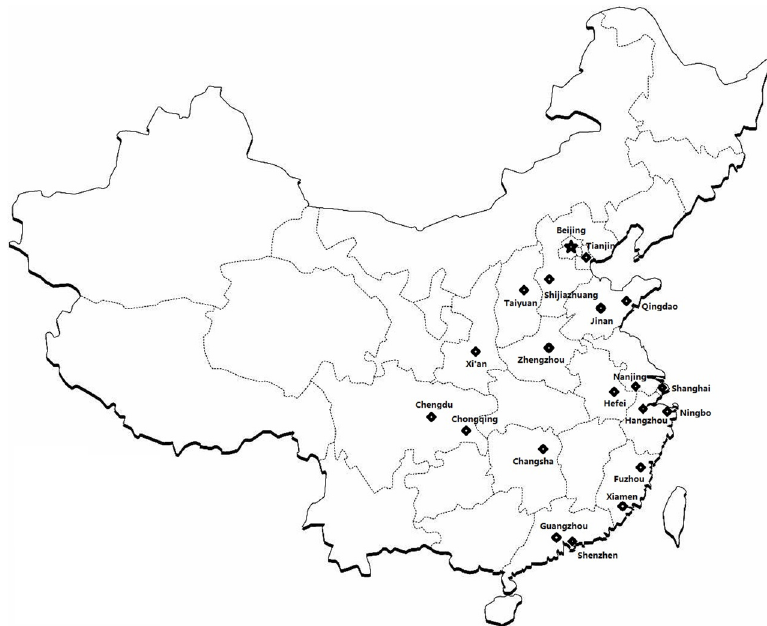
Figure 1. Location of 20 large cities in China selected for sampling. Table 2. Serological positivity for Anaplasma spp., Borrelia spp., Ehrlichia spp. and Babesia gibsoni infection in pet dogs by ELISA. Sample Borrelia spp. Ehrlichia spp. Anaplasma spp. Babesia